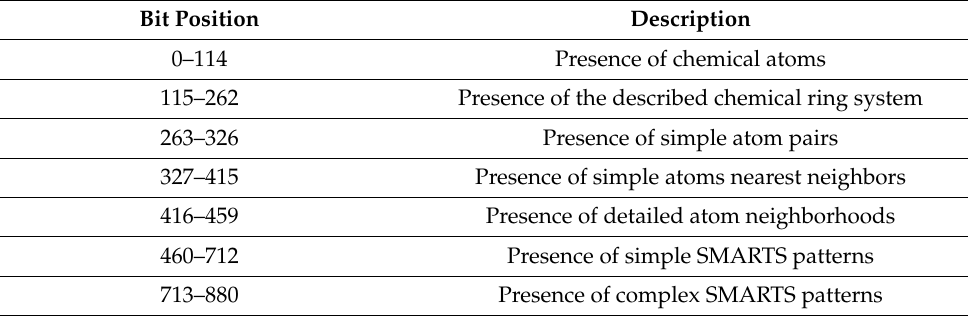
Table 6. PubChem substructure fingerprints